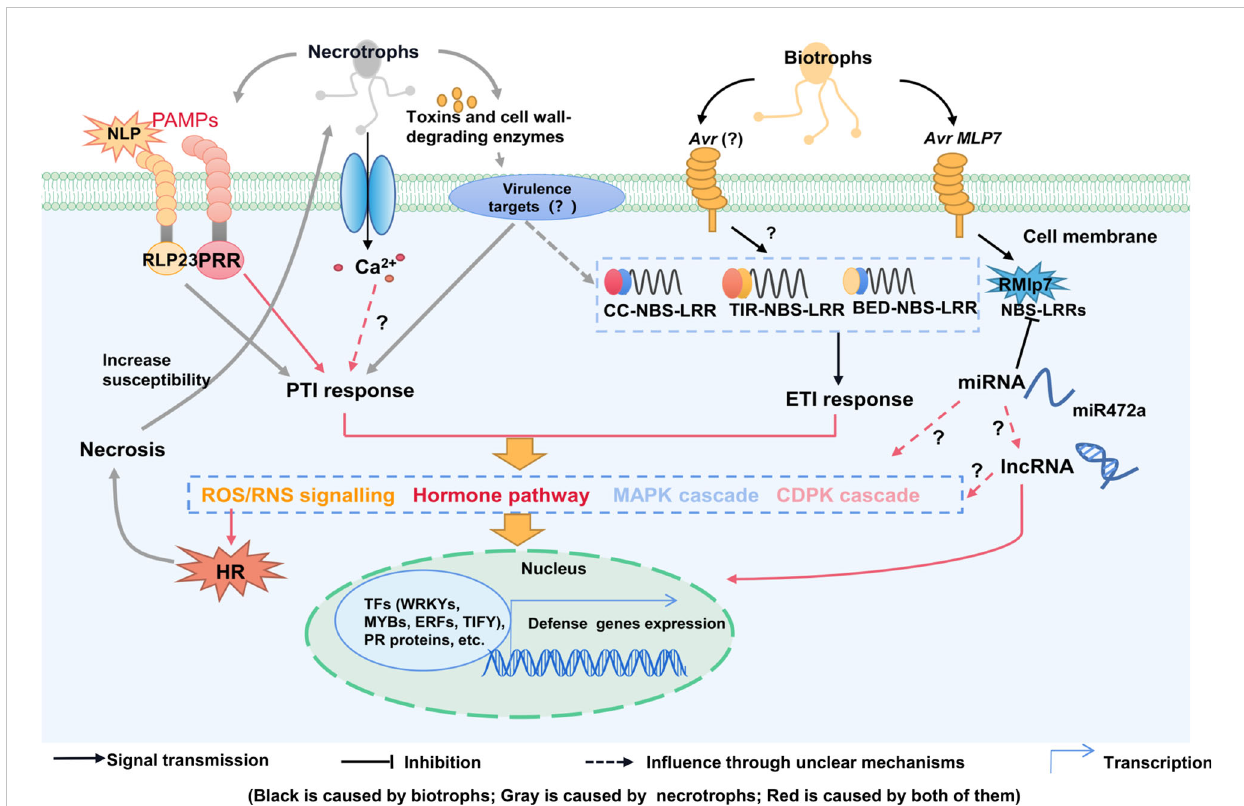
FIGURE 1 A model of poplars immunity to fungal pathogens. When plants attacked by biotrophic pathogens, PRRs recognize extracellular pathogenic characteristics and activate PTI, R proteins (NBS-LRRs) recognize intracellular effector proteins from pathogens and activate ETI. They induce a series of defense responses including the production of ROS, RNS, phytohormone, CDPKs and MAPK signals. But necrotrophic fungus may only recognized by PRRs. Many defensive genes and transcription factors are key players, including PR , MYB, WRKY, TIFY, and ERF, lncRNAs and miRNAs also participate in defense responses against fungal pathogens. miRNAs also play a role in the regulation of NBS-LRR. Avr , avirulence gene ; CDPK, calcium-dependent protein kinase; ETI, effector-triggered immunity; HR, hypersensitive response; lncRNAs, long ncRNAs; MAPK, mitogen-activated protein kinase; miRNAs, microRNAs; PCD, programmed cell death; PR, pathogenesis-related proteins; PRRs, pattern recognition receptors; PTI, pattern-triggered immunity; ROS, reactive oxygen